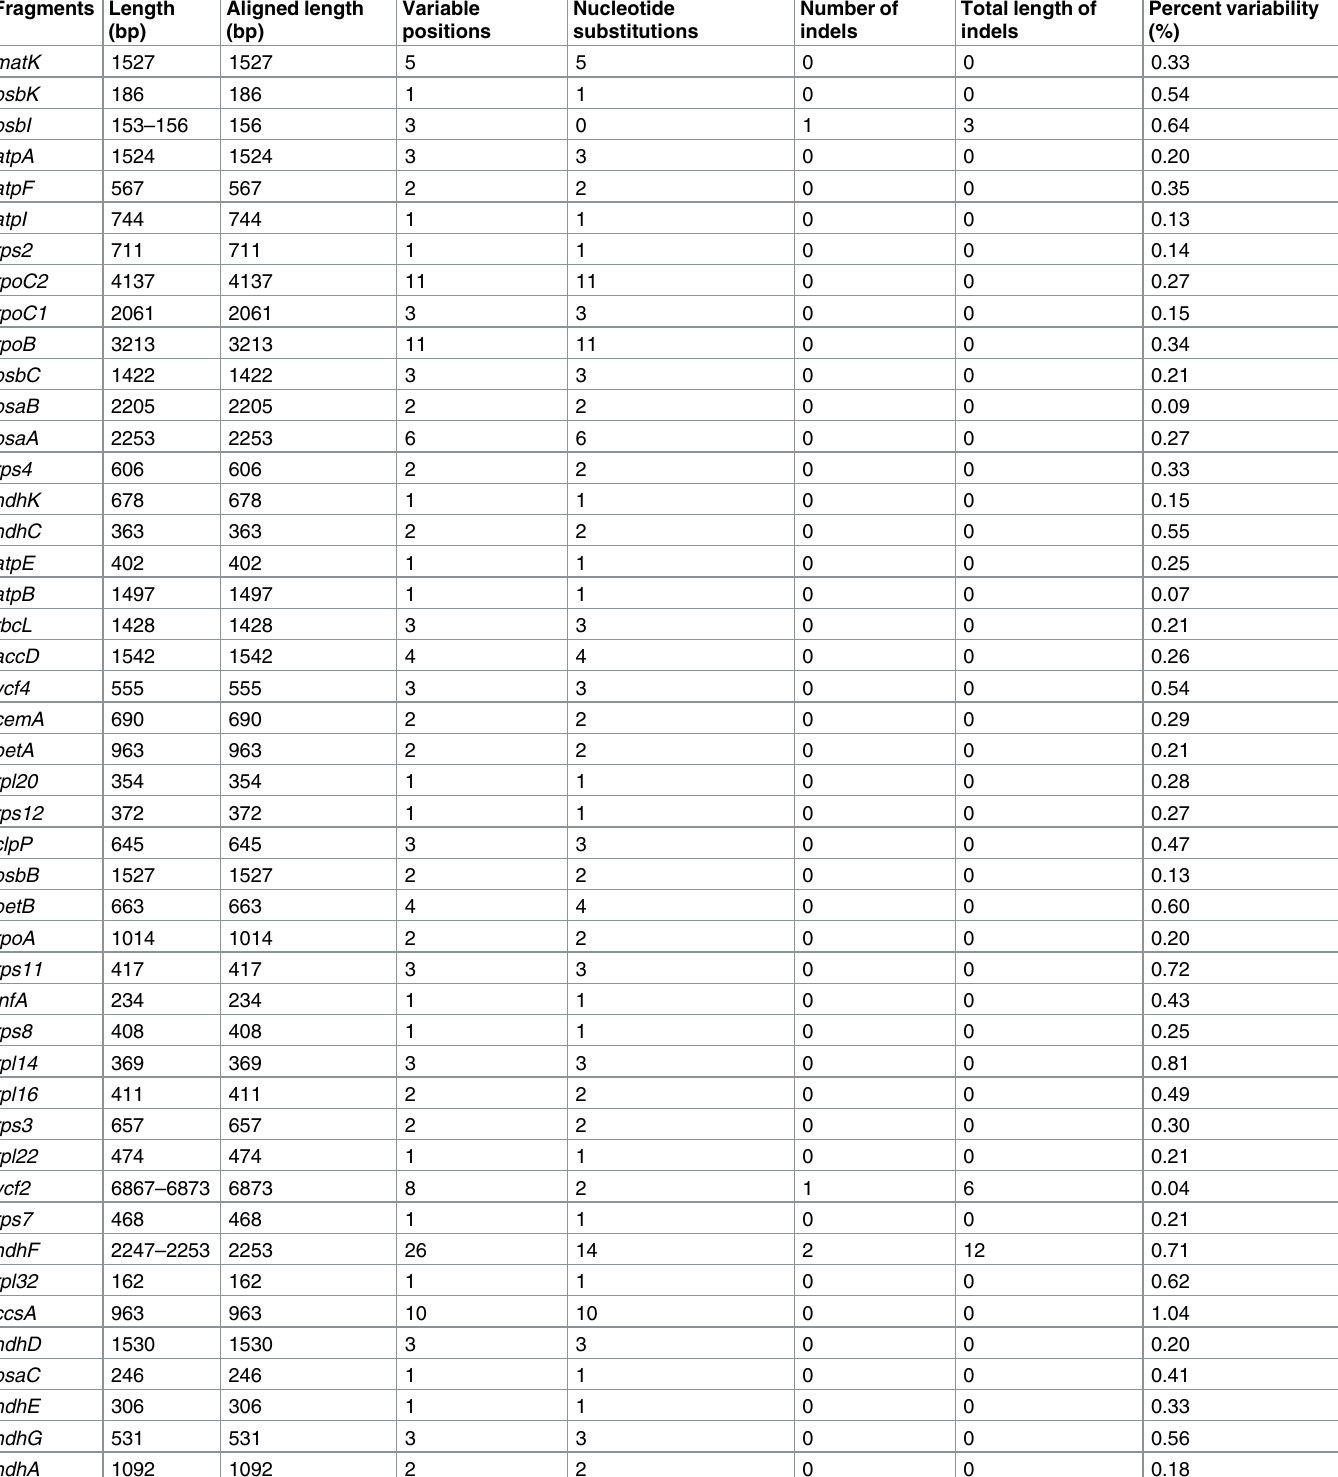
Table 2. Sequence divergence of 49 variable coding regions ( > 150bp) from 11 chloroplast genomes of Schima , with one of the Inverted Repeat regions